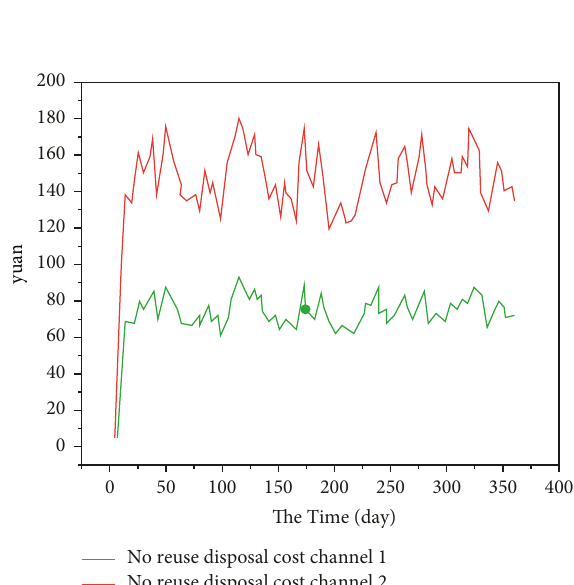
Figure 12: Comparison of the benefits of recycling.